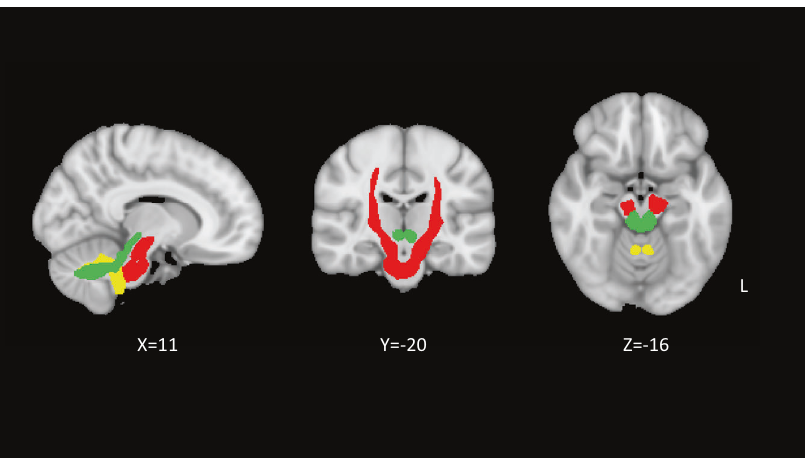
Fig. 1 Tracts of interest. The bilateral cortico-ponto-cerebellar tracts, the superior cerebellar tracts, and the inferior cerebellar tracts, de fi ned by tractography-based atlas, are presented in red, green, and yellow respectively. L =